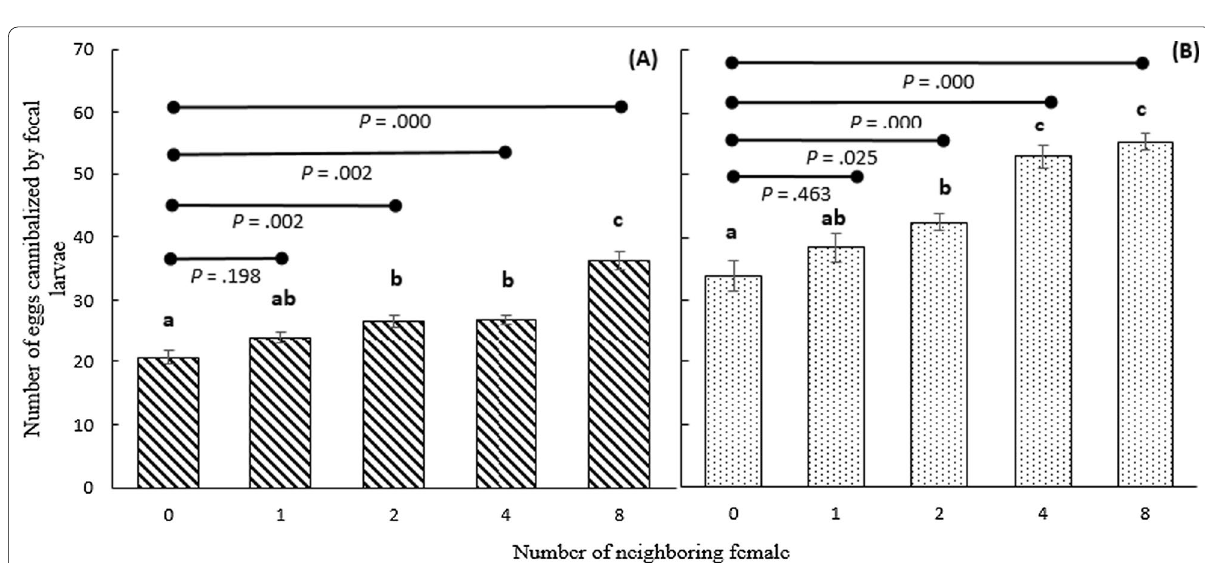
Fig. 4 Number of eggs (means SE, where N 8 for each bar) cannibalized by C. carnea focal larvae ( A ± = without choice. Horizontal lines with circular ends indicate comparison of egg cannibalism between focal larvae with (i.e. one, two, four or eight) neighboring larvae, separately. Difference in letters above the bars indicates significance ( p < 0.05) with respect to control (0 neighbor),